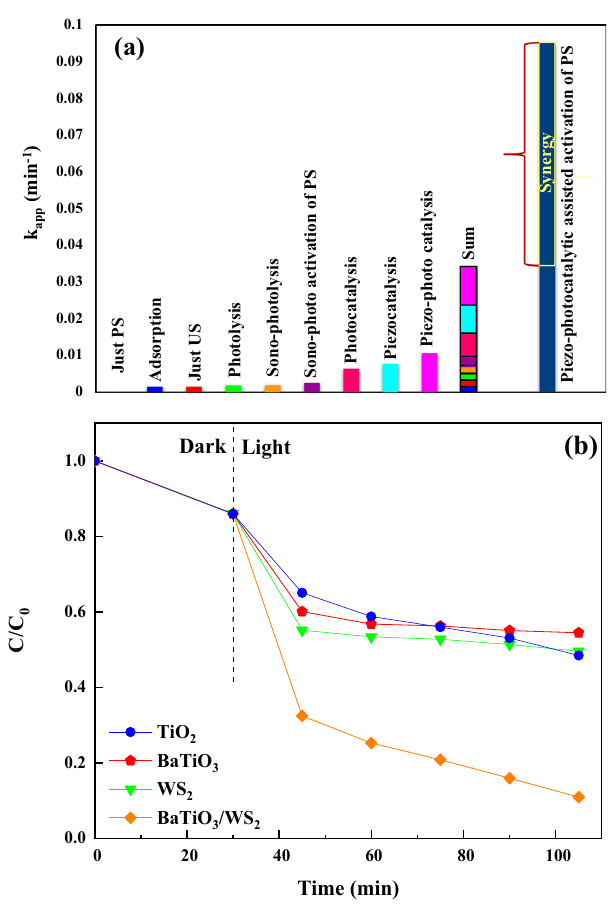
Fig. 4 The ef fi ciency of the BaTiO 3 /WS 2 composite in the piezo- photocatalytic activation of persulfate. a Synergistic effect of the piezo- photocatalytic assisted activation of persulfate. b Comparison of the piezo-photocatalytic activity of the BaTiO 3 /WS 2 composite with the pure TiO 2 , BaTiO 3 , and WS 2 and. Experimental conditions: Catalyst concentration = 1.0 g L − 1 , [OFL] = 20 mg L − 1 , [PS] = 10 mM, pH = 6.5. The error bars were not shown, as they were smaller than the data